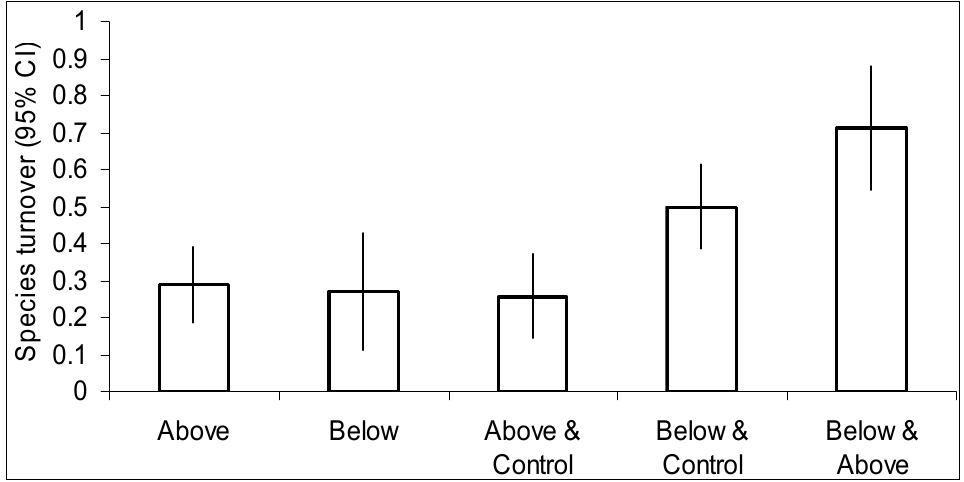
Figure 3. Mean turnover (with CI) for above dam, below dam, above and control, below and control and above and below